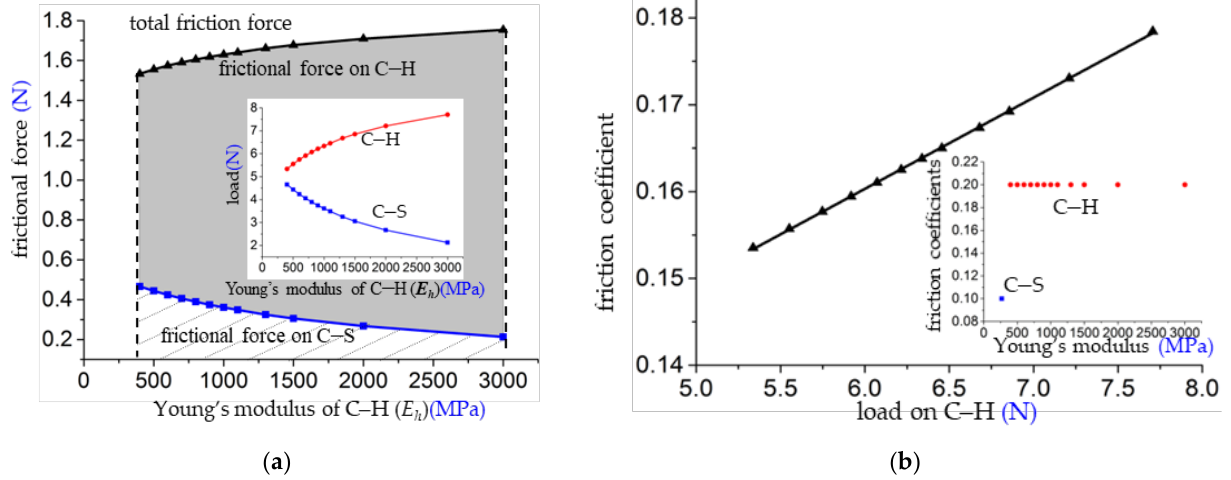
Figure 3. Curves of friction force and friction coefficient for BHSIMs with varied elastic modulus of hard phase ( E h ). ( a ) friction force (inset is the load); ( b ) friction coefficient (inset is the friction coefficient).